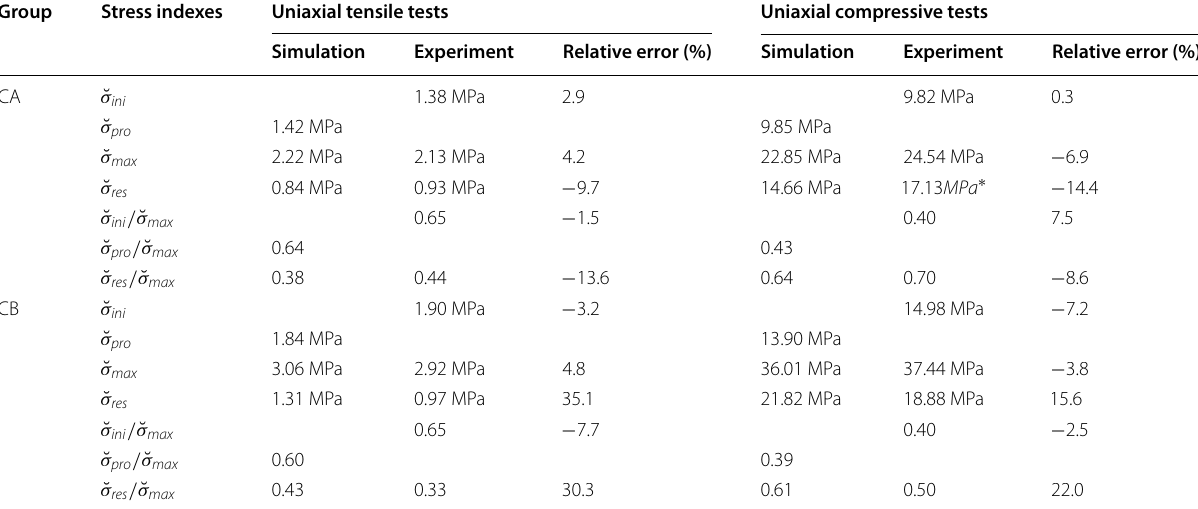
* The value of residual stress corresponding to double peak strain is taken from empiricalcurve.